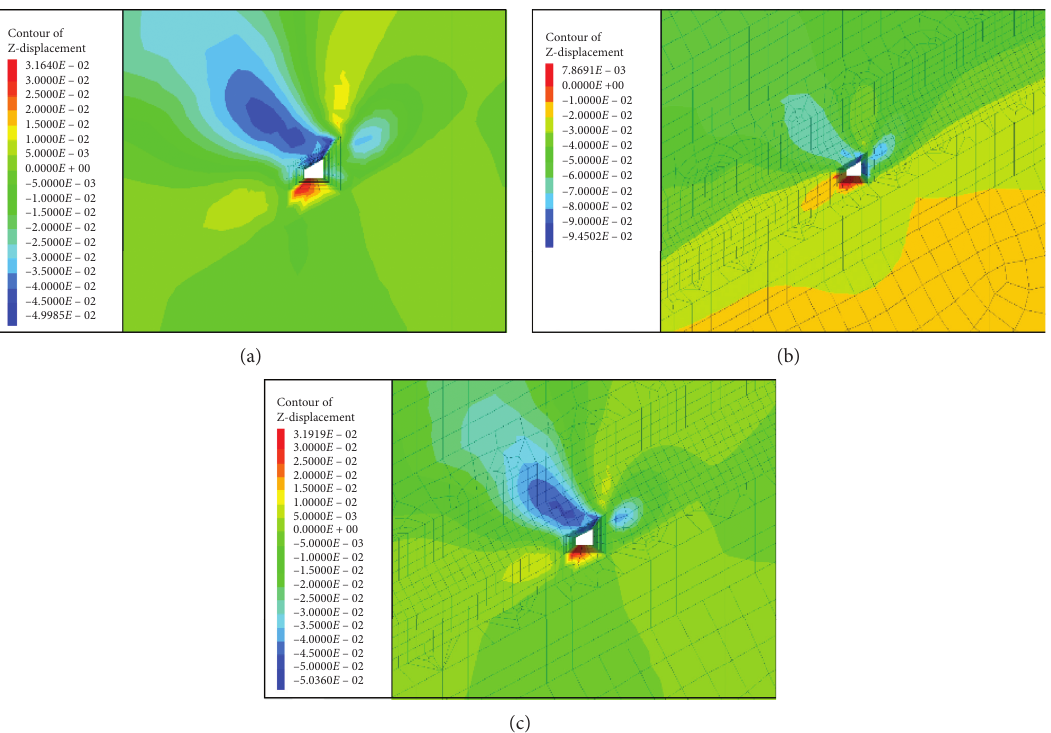
Figure 7: Displacement distribution. (a) Unsupported. (b) Bolt support. (c) Bolt-anchor cable support.